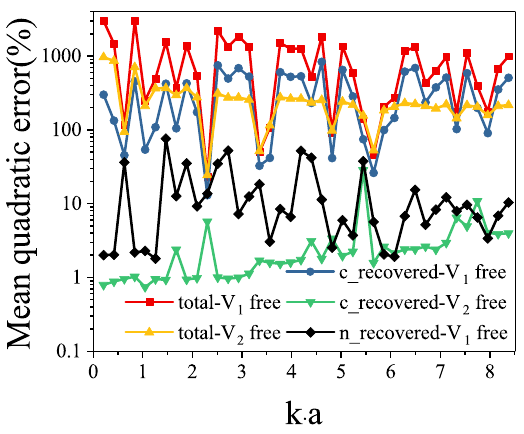
Figure 9. Mean quadratic errors on the measurement surface.